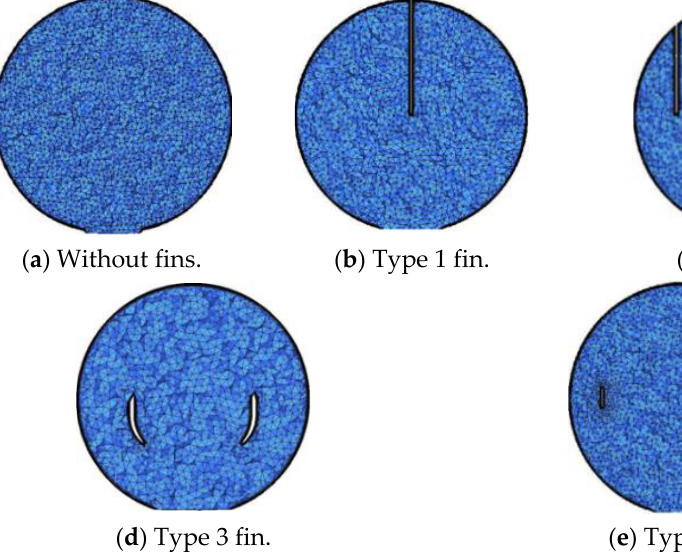
Figure 3. Computational grid for the flow.